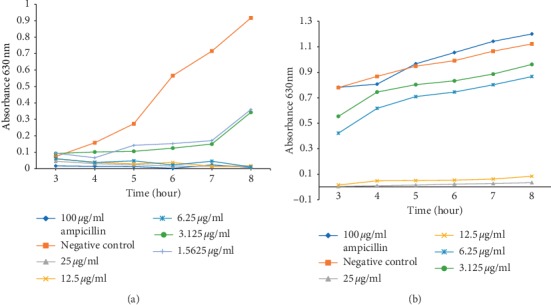
Growth-inhibitory effects of Molecule 7 against P. aeruginosa (ATCC 22108) and K. pneumoniae (ATCC 700603). (a) The time curve of Molecule 7 against P. aeruginosa (ATCC 22108). (b) The time curve of Molecule 7 against K. pneumoniae (ATCC 700603). The tested strain was cultured in 96-well plates, and the OD620 was measured at each time point. The error bars indicate standard deviations from the mean.